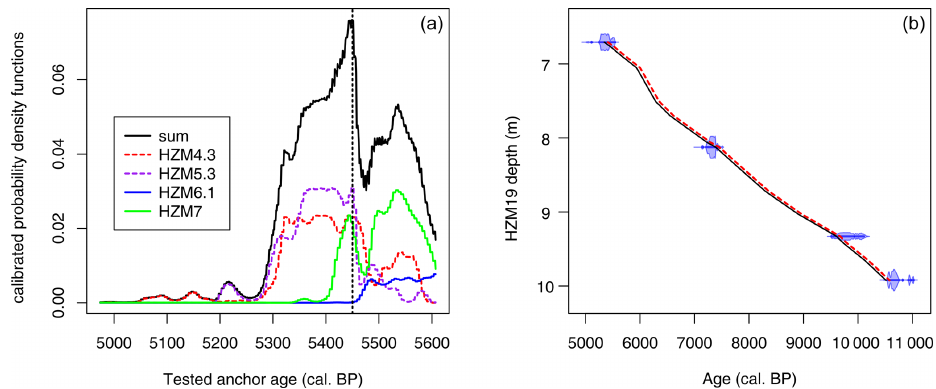
Figure A4. Calculations for the floating VT-99 chronology of Model D, section 3. (a) Calculation of the anchoring age for the varve chronology based on matched and summed calibrated probability density function values of all radiocarbon samples within this section. The maximum summed probability occurs at an anchor age of 5450calBP. (b) Original VT-99 (black line) vs. floating VT-99 ( + 65 years, dotted red line) with calibrated radiocarbon samples vs.